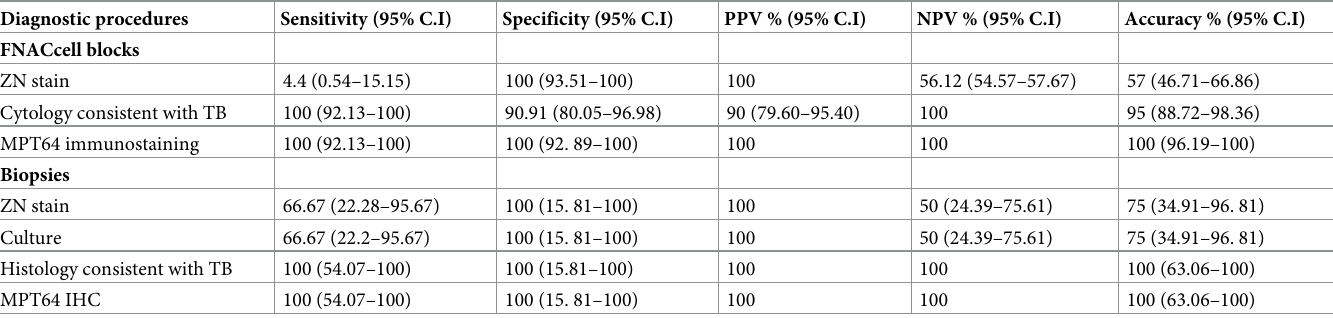
Table 4. Diagnostic validation of MPT64 immunostaining in cell blocks and biopsy specimens (all values are in percentage). Diagnostic